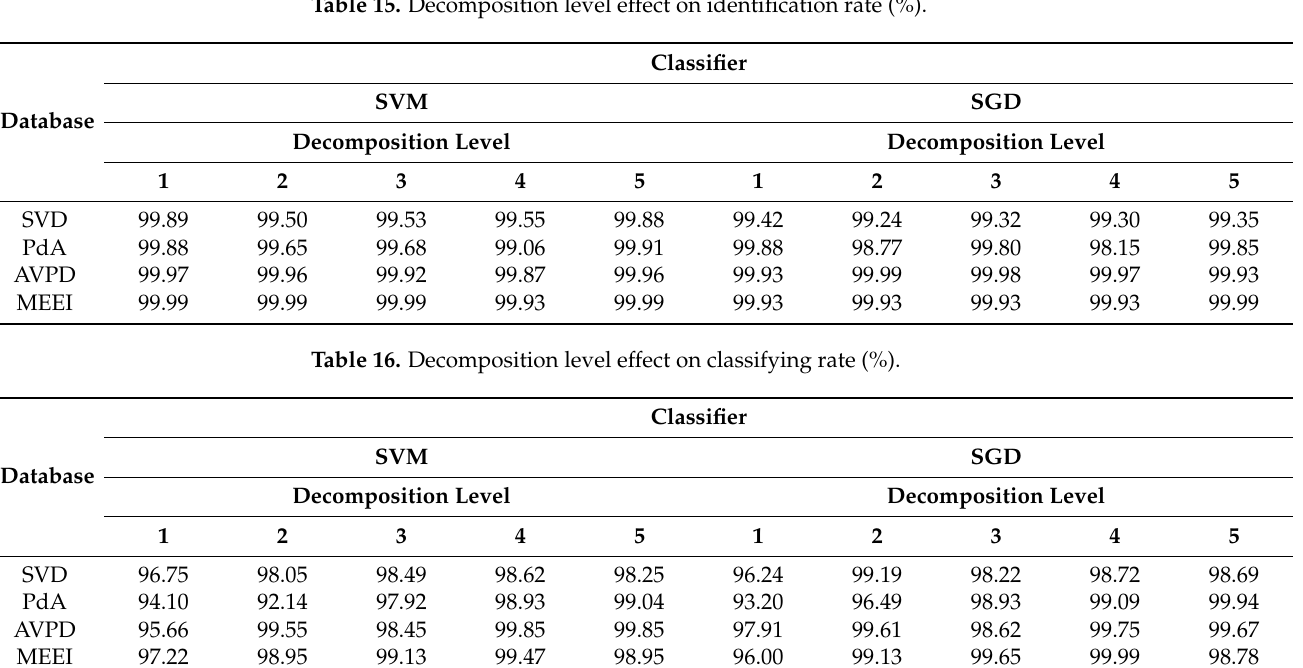
Table 15. Decomposition level effect on identification rate (%).